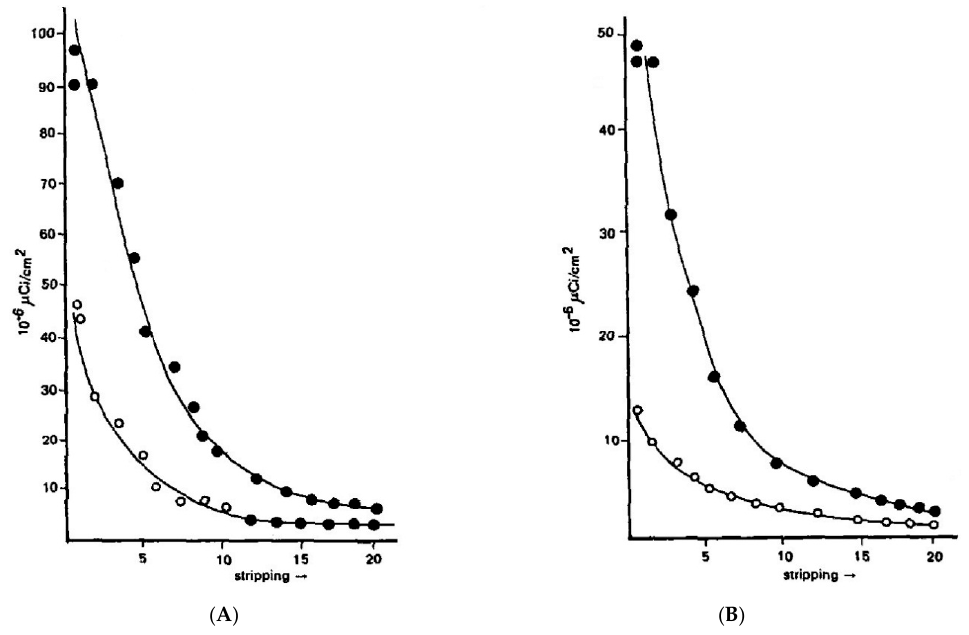
Figure 17. Distribution of PPD ( A ) and HC Blue 1 ( B ) in the horny layer immediately after coloring (solid circles) and 16 h after coloring (open circles).